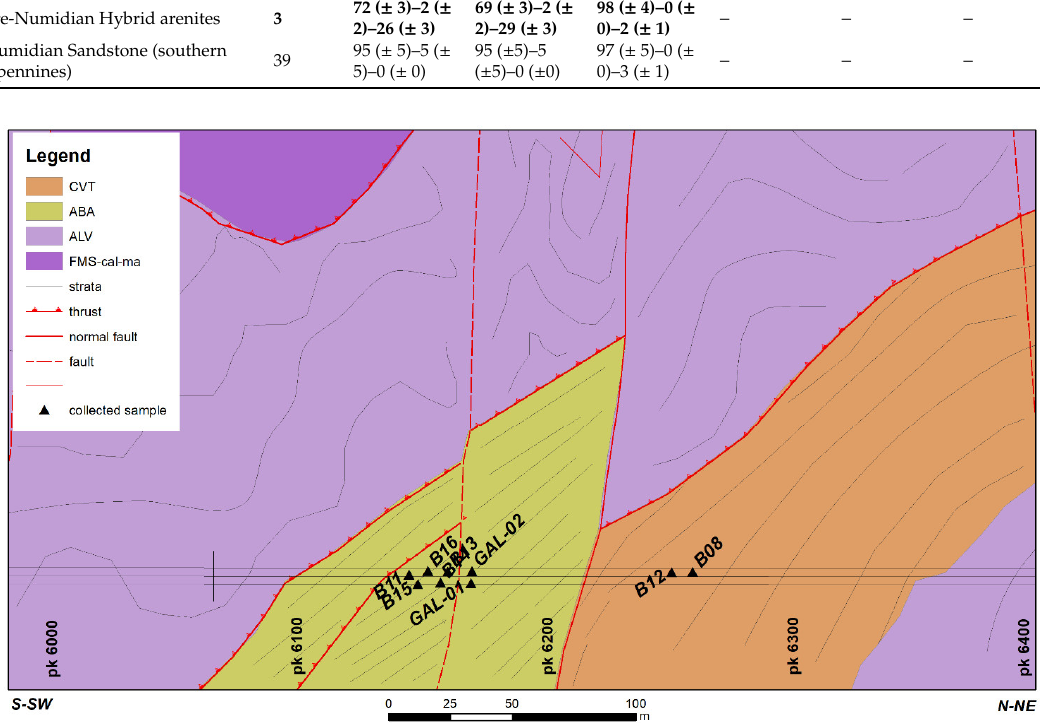
Figure 9. Location of sample collected along tunnel section from 6100 m to 6300 m chainage (pk). Geological unit codes: ALV, Argille Varicolori Superiori Fm.; ABA, Albanella/Corleto unit; CBI, bio-litoclastic rudist limestone fm.; CVT, Castelvetere Formation; FMS, Monte S. Arcangelo Fm. with calcareous-marly lithofacies (FMS-cal-ma).